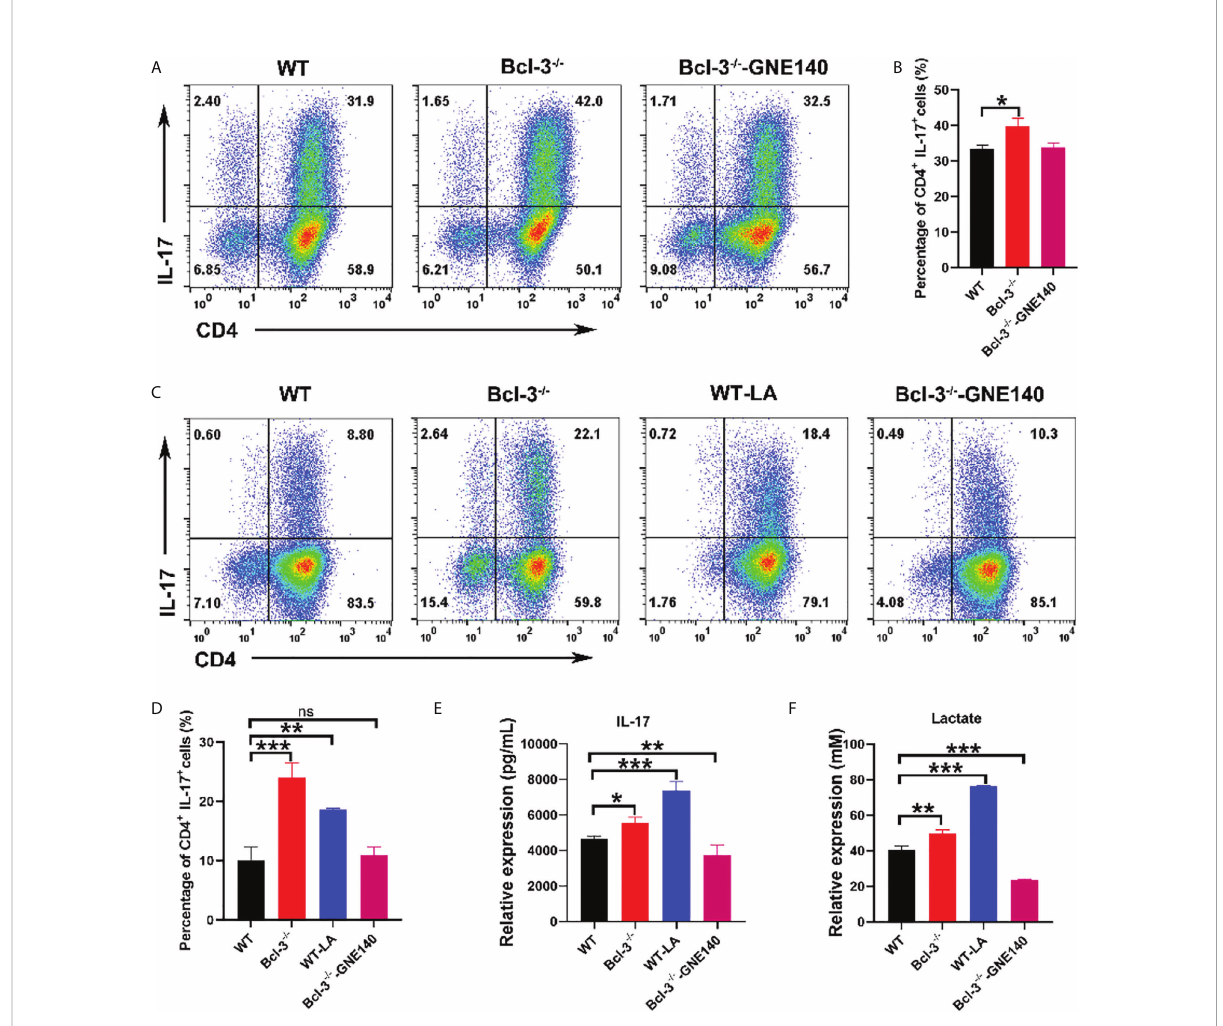
FIGURE 3 Bcl-3 regulates the differentiation of Th17 cells by lactate. (A) Th17 cells from the spleen lymphocytes of WT mice and Bcl-3 -/- mice induced using in vitro polarization assay, 10 m M GNE-140 was added to Bcl-3 -/- group for three days, and Th17 cells were analyzed by FACS. (B) Statistical analysis of Th17 cells. (C) Th17 cells from the spleen lymphocytes of WT mice and Bcl-3 -/- mice induced using in vitro polarization assay, 10 m M GNE-140 was added to Bcl-3 -/- group, 25 mM lactate were added to WT group for three days, and Th17 cells were analyzed by FACS. (D) Statistical analysis of Th17 cells. (E) IL-17 secretion in supernatant of Th 17 cells were detected by ELISA. (F) Lactate secretion in supernatant of Th 17 cells were detected by lactate detection kit. n = 3 for each group. Data above are representative of 3 independent experiments. *P <0.05, **P <0.01, ***P <0.001, “ ns ” , no signi fi